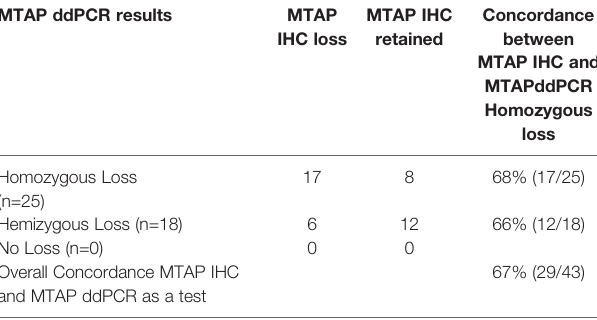
TABLE 9C | Comparison of methylthioadenosine phosphorylase (MTAP) immunohistochemistry (IHC) and MTAP droplet digital PCR (ddPCR) homozygous and hemizygous deletion, and no loss (retention).